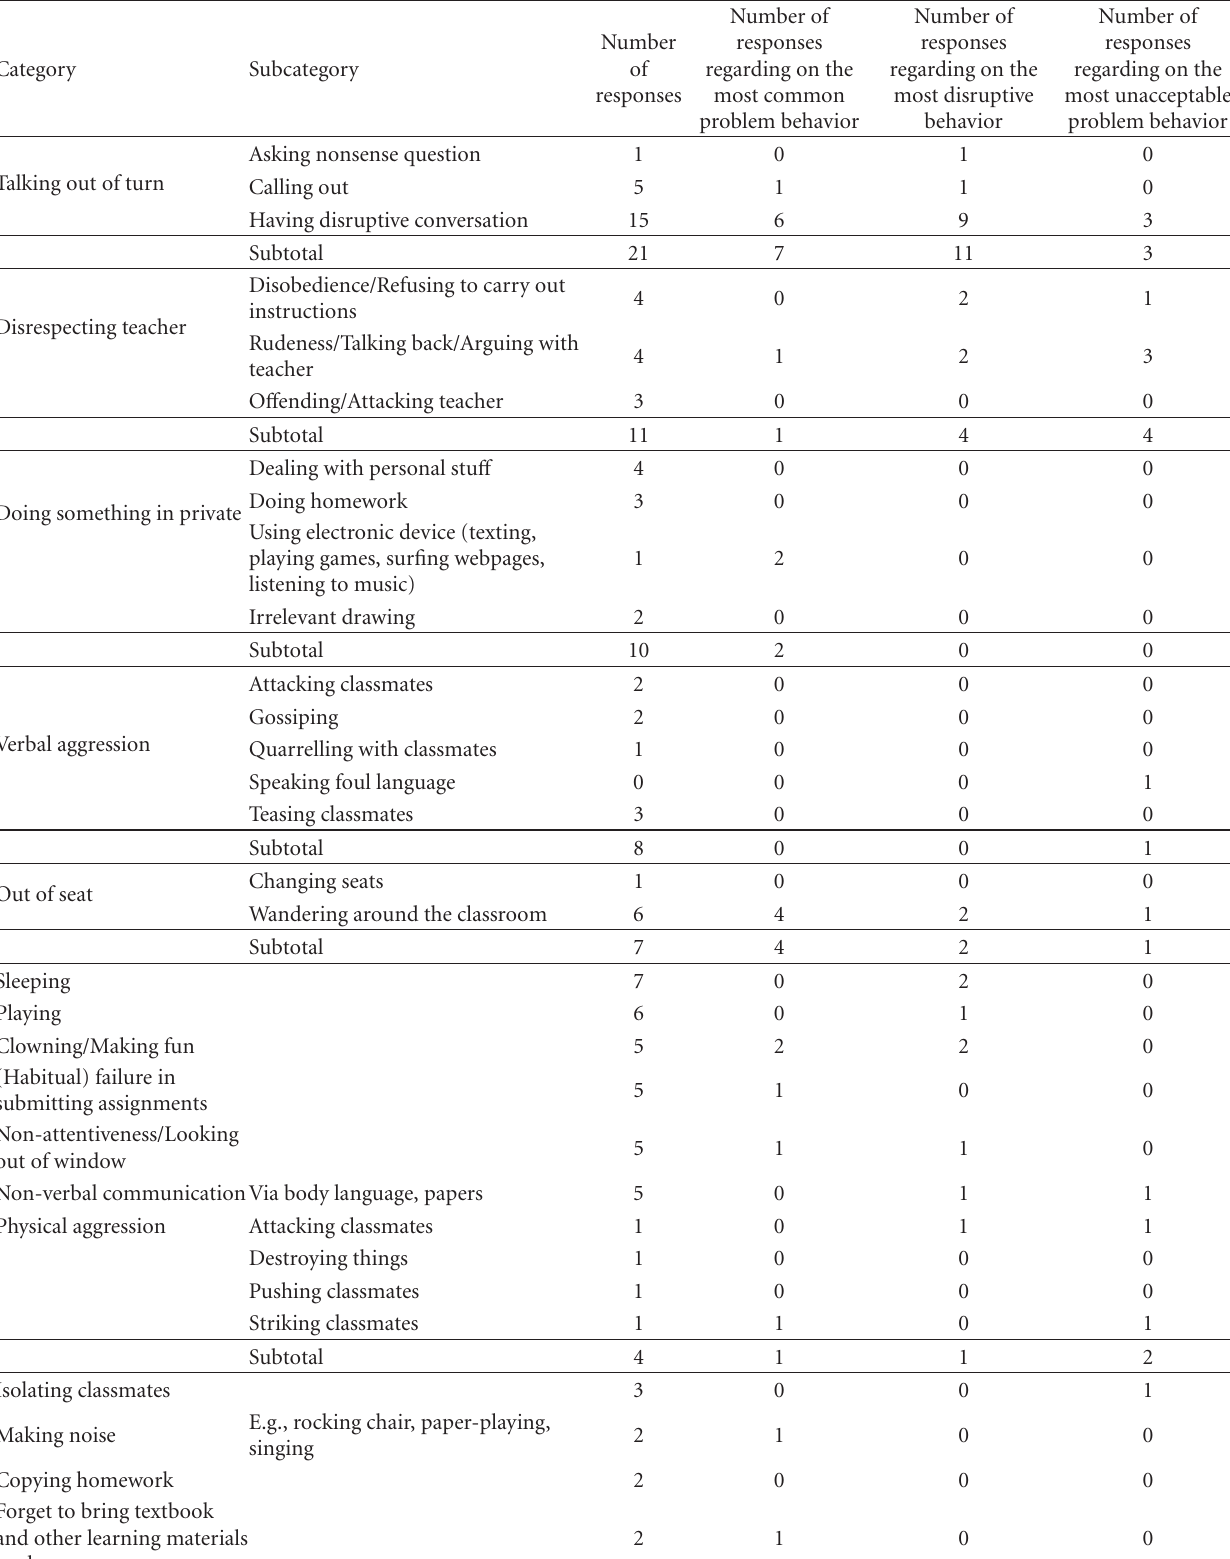
Table 1: A Summary of students’ perceptions of student problem behaviors inside classroom ( N =